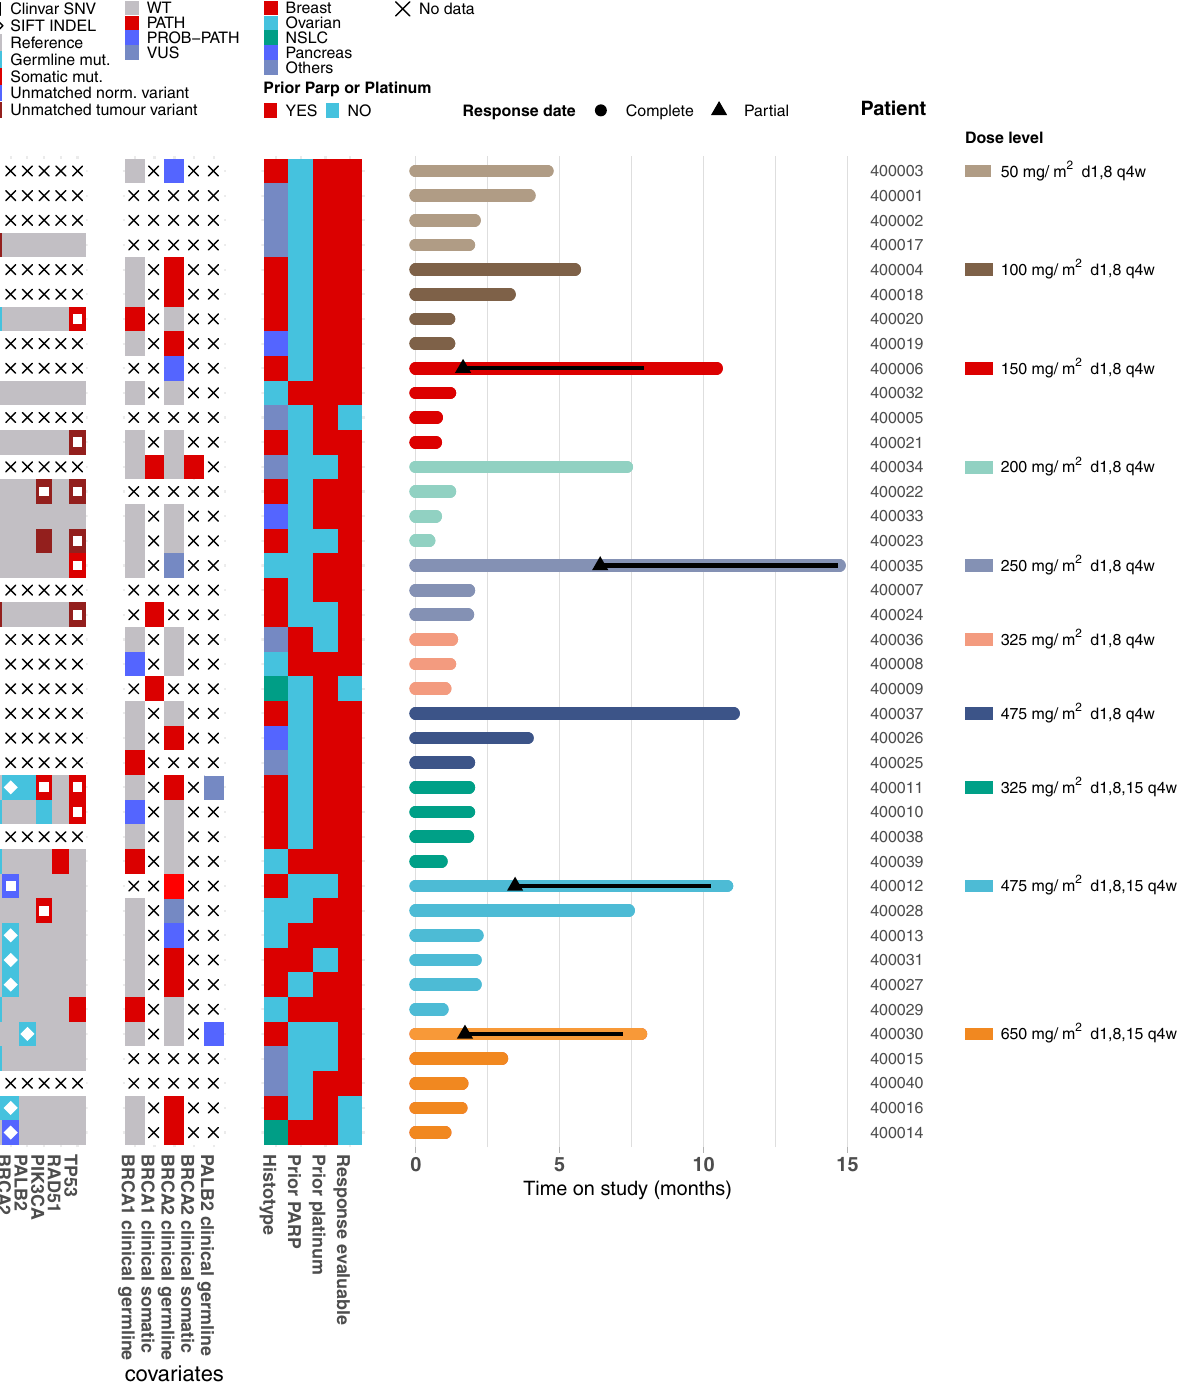
Fig. 2 Combined waf fl e-swimmers plot for genotypes, clinical characteristics, and duration of responses for patients treated with CX-5461. Left waf fl e panel WGS functional classi fi cation; color box; cosmic/fathmm SNV or indel; color box with diamond, SIFT-indel pathogenic; color box with square clinvar pathogenic SNV. Left-center panel clinical germline testing alleles reported as pathogenic/prob-pathogenic, VUS, WT for BRCA1/2 and PALB2 . Center-right waf fl e panel, histotypes, prior-treatment, response evaluable; Right panel, swimmers plot of responses by dose level. Solid colour lines, time on the study (months); solid black line inset, duration of response, response end at end of the black line. n = 40 patients, source data are provided as a Source Data fi